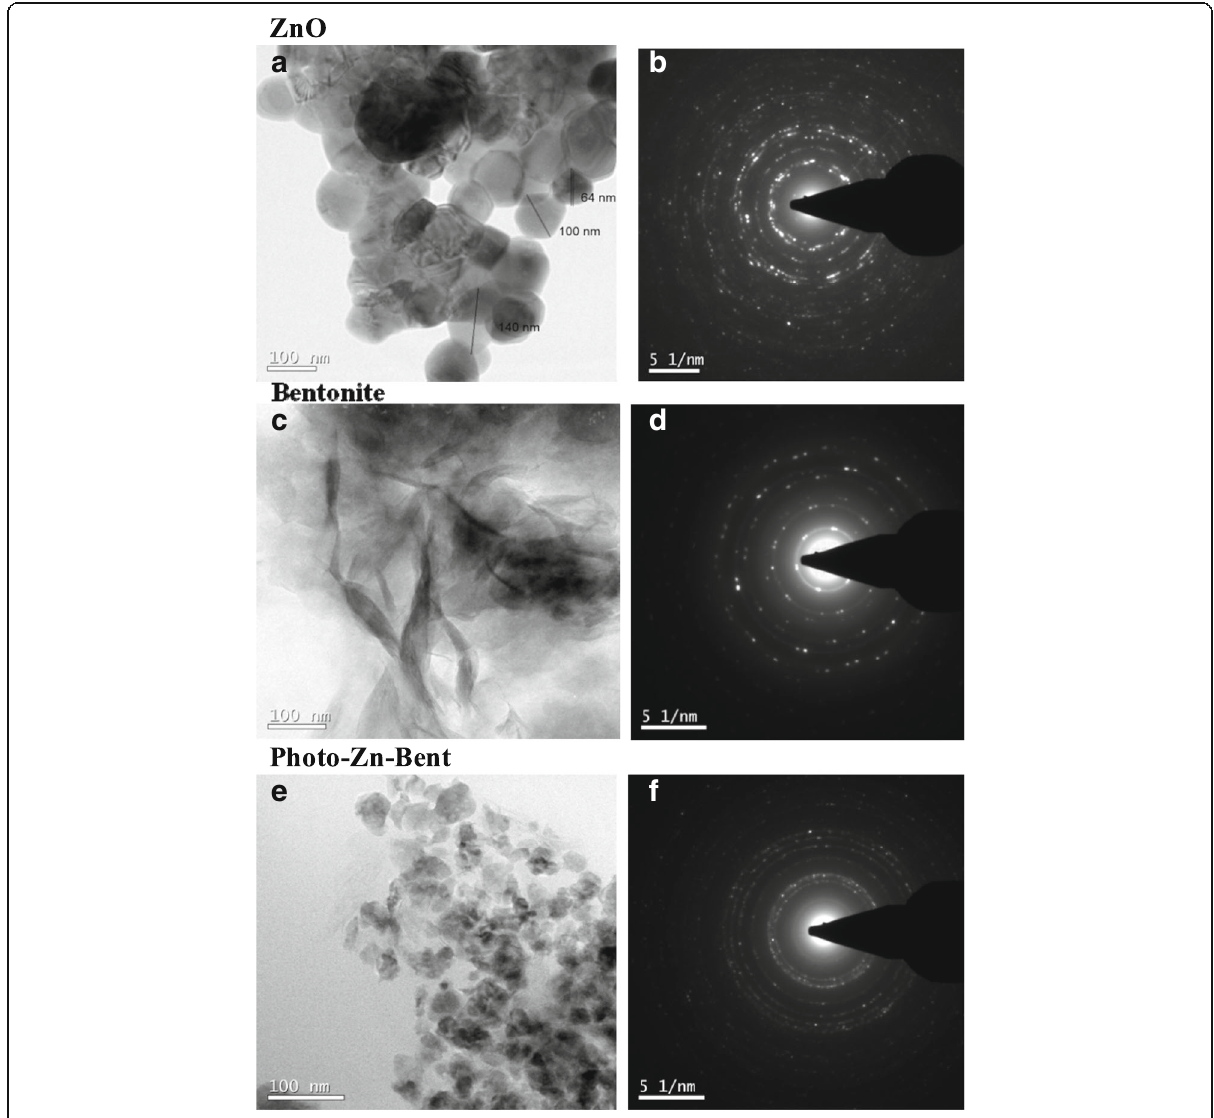
Fig. 2 High resolution transmission electron microscopy images ( a , c , e ) and selected area diffraction pattern ( b , d , f ) of samples. ( a , b ) ZnO, ( c , d ) Bent and ( e , f )